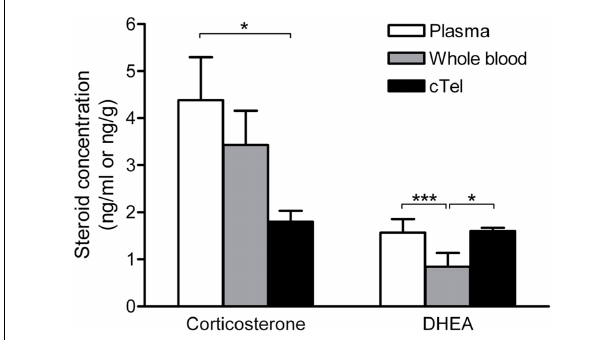
FIGURE 3 | Corticosterone and DHEA levels in zebra finch plasma, whole blood, and brain (cTel, caudal telencephalon ) . For corticosterone, brain levels are significantly lower than plasma levels but not significantly lower than whole blood levels. For DHEA, brain and plasma levels are similar, but brain levels are significantly higher than whole blood levels. Thus, the use of plasma samples (which overestimate circulating steroid levels) or whole blood samples can lead to very different interpretations when comparing tissue steroid levels against circulating steroid